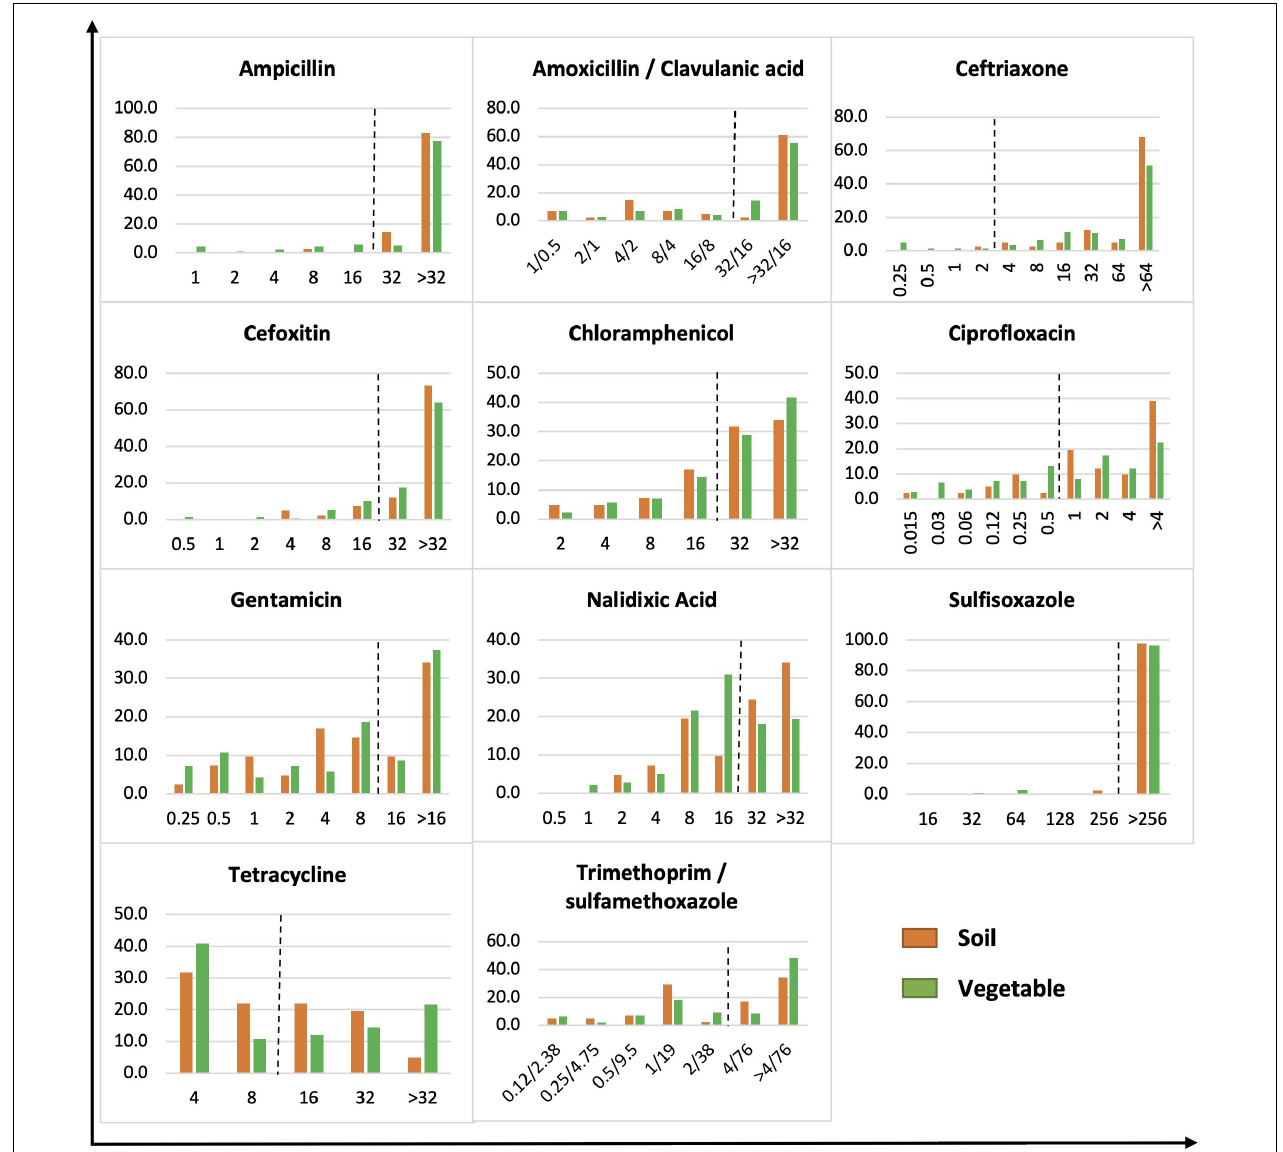
FIGURE 2 | MIC distribution of gram-negative bacteria from soil and vegetable origin. X -axis is MIC in µ g/ml. Y -axis is % of soil or vegetable isolates. The dot line on each figure stands for the breakpoint of E. coli against the specific